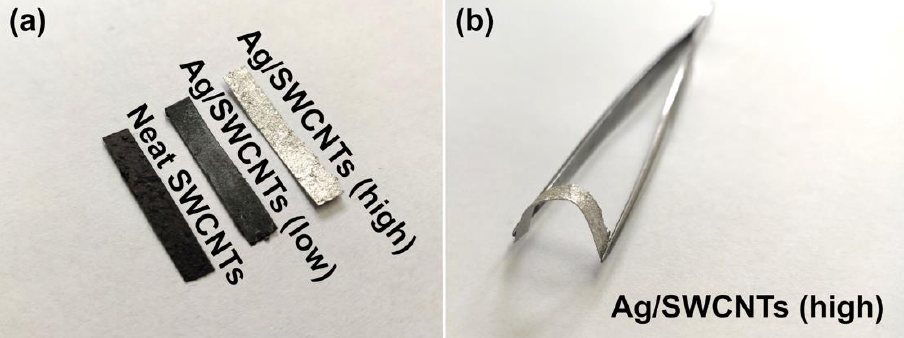
Figure 5. ( a ) The visual appearance of the materials: neat SWCNT film, lightly-doped with Ag, heavily-doped with Ag. ( b ) Demonstration of the flexibility of the heavily-doped SWCNT film.